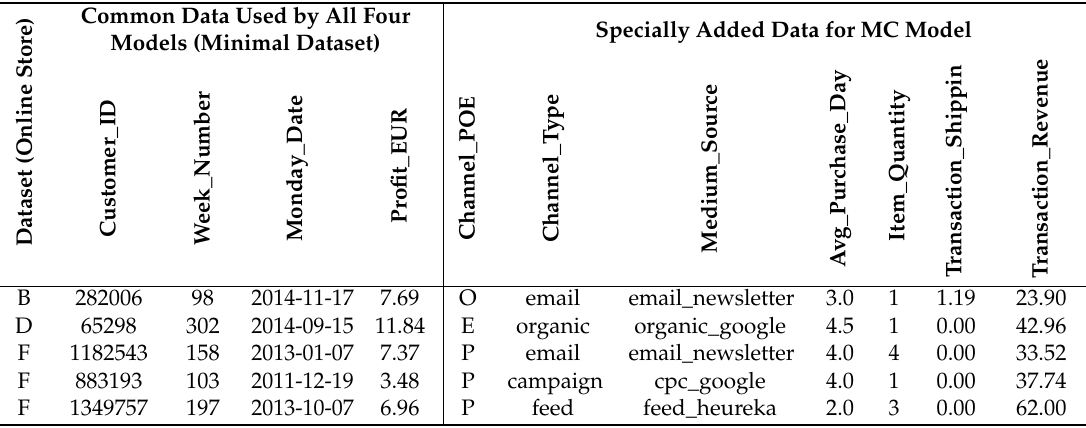
Table 1. Five randomly selected rows from the complete dataset, consisting of the minimal dataset and data added especially for the MC model.